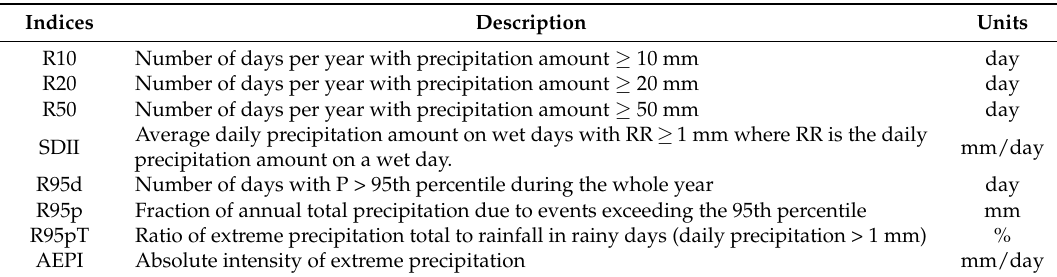
Table 2. Definitions of the extreme precipitation